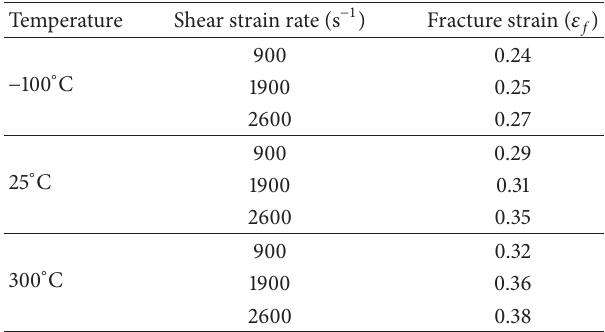
Table 1: Variation of fracture shear stress with fracture shear strain as a function of strain rate and